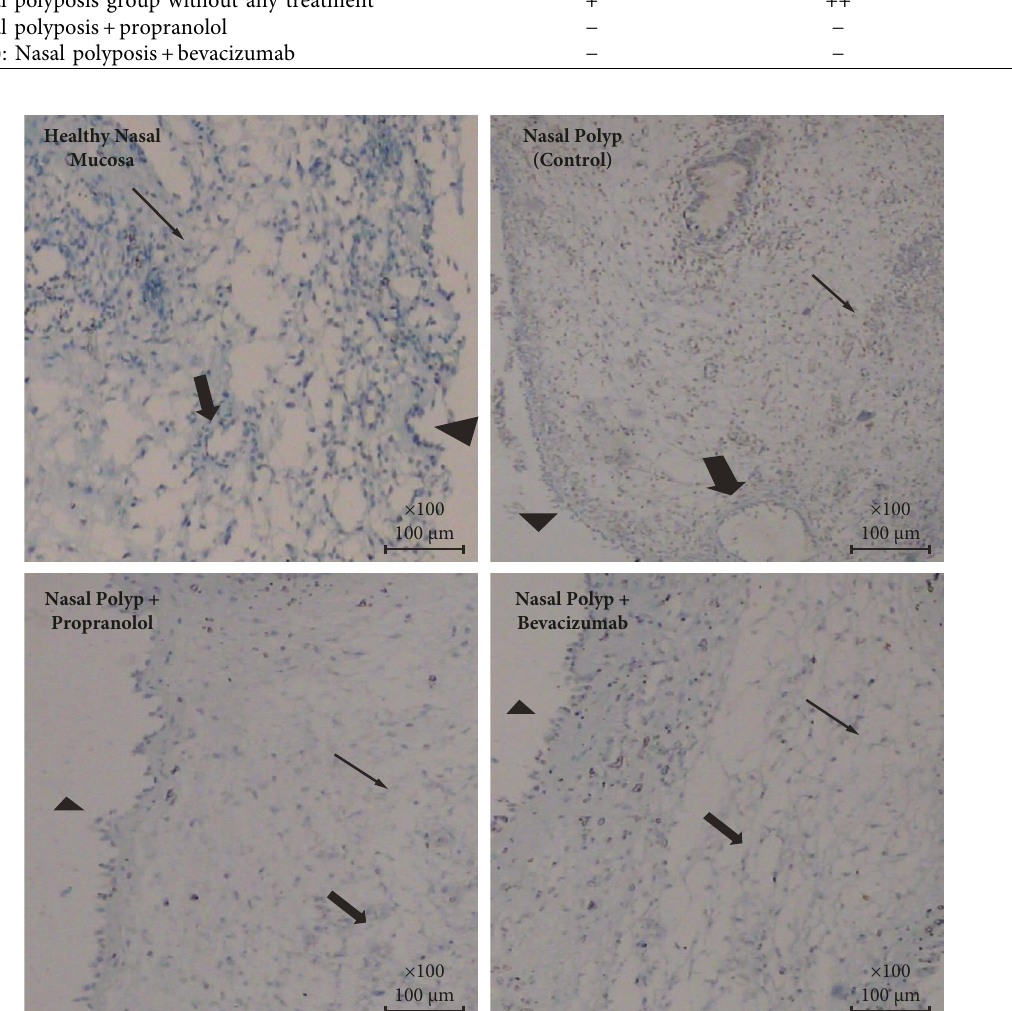
Table 1: Expression of VEGF-A, Ang-1, Ang-2 in each group. ( − : negative expression, +: Low expression, ++: Moderate expression and +++: High expression). Group 1: Healthy nasal mucosa (control group) − + +++ Group 2: Nasal polyposis group without any treatment + ++ + Group 3: Nasal polyposis+propranolol − − ++ Group 4 ( n :7): Nasal polyposis+bevacizumab